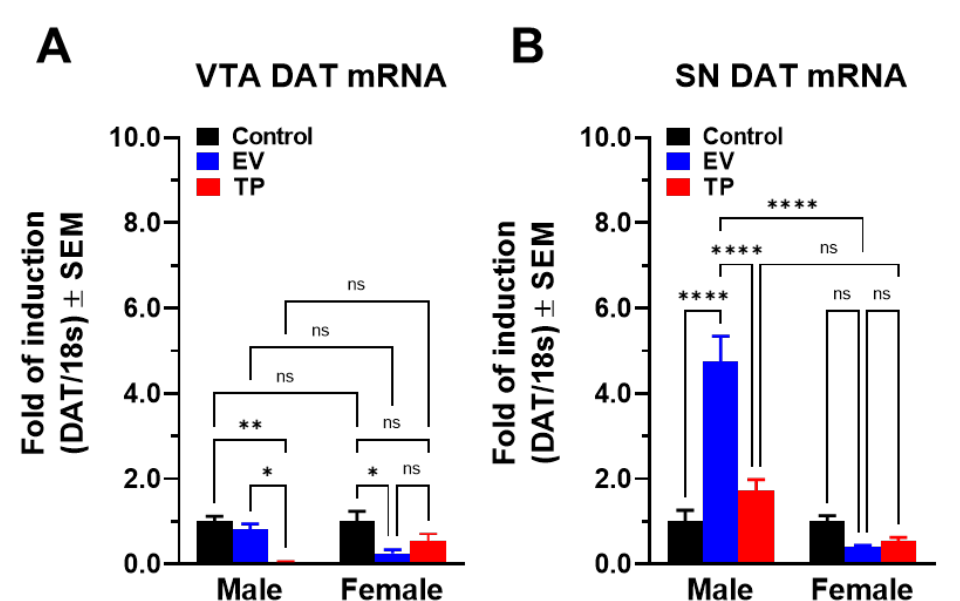
Figure 5. DAT mRNA expression in ventral tegmental area (VTA) ( A ) and substantia nigra (SN) ( B ) of male and female rats neonatally treated with estradiol valerate (EV) or testosterone propionate (TP). All data are normalized for 18S expression levels within the same sample. Results are expressed as fold induction relative to control group and represent the mean ± SEM. Data were analyzed by two-way ANOVA (* p < 0.05; ** p < 0. 01; **** p < 0.0001).